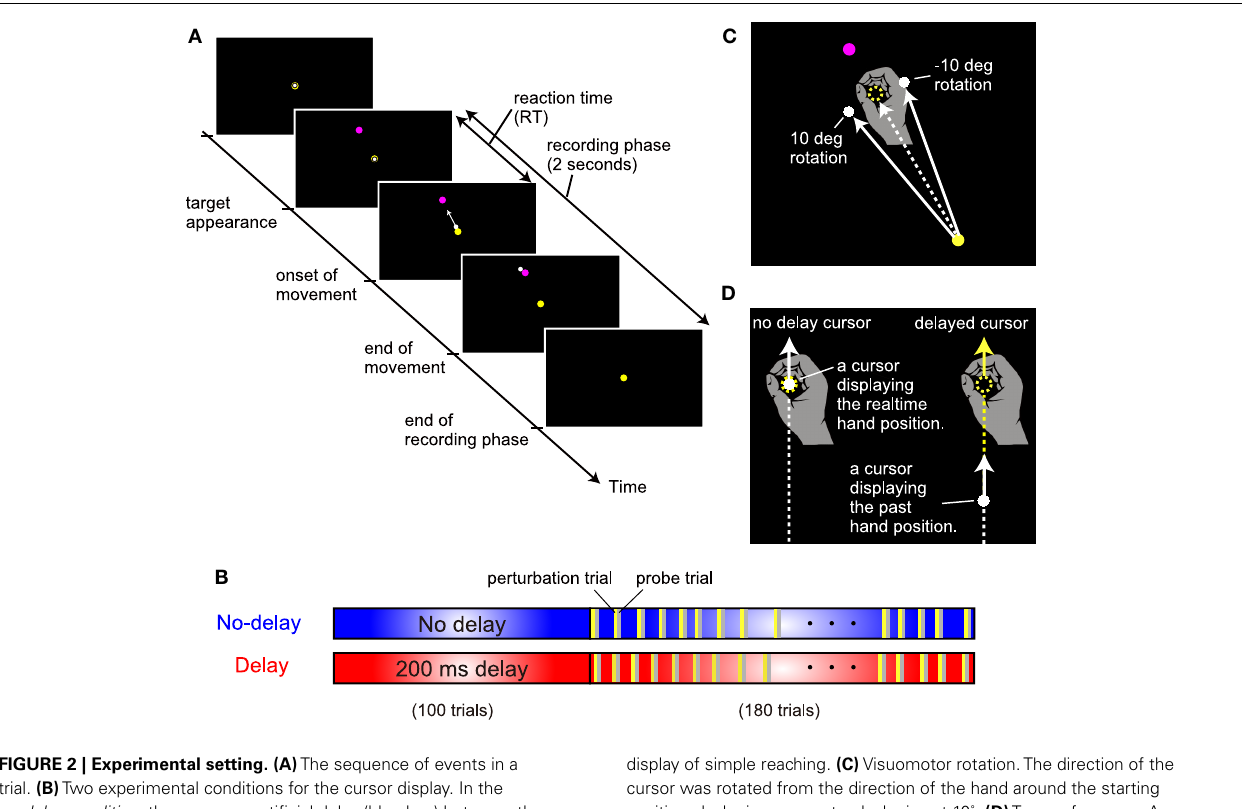
FIGURE 2 | Experimental setting. (A) The sequence of events in a trial. (B) Two experimental conditions for the cursor display. In the no-delay condition , there was no artificial delay (blue box) between the hand and cursor in the simple reaching task. In the delay condition , there was an artificial delay of 200ms between the hand and cursor